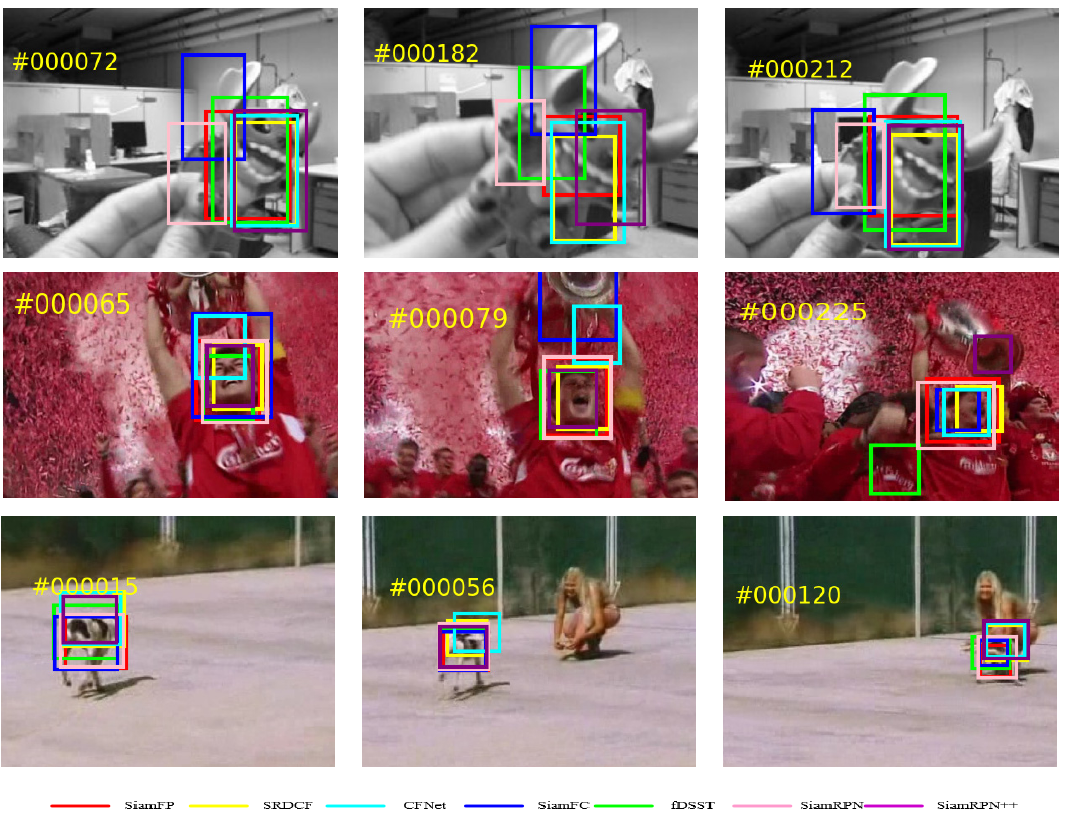
Figure 6. Tracking Results of SiamFP with Six Trackers on Video Sequences of OTB100.